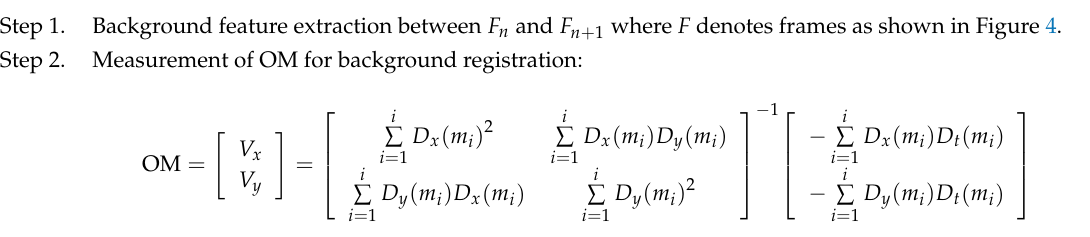
Algorithm 1. Background Registration-Based Adaptive Noise Filtering